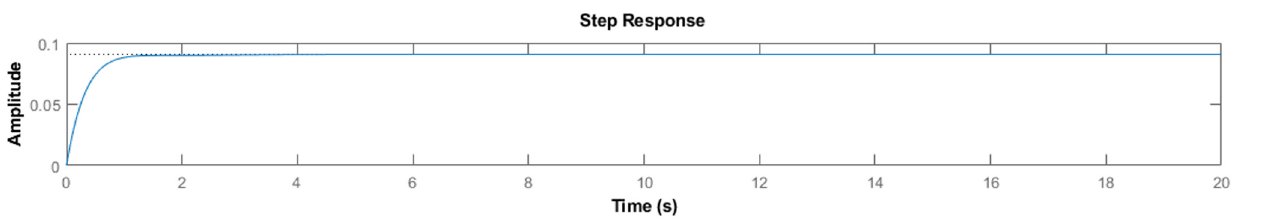
Figure 4. Output response with 𝐸 (cid:3007)(cid:3005) = 1 , 𝑃 (cid:3040) = 1.